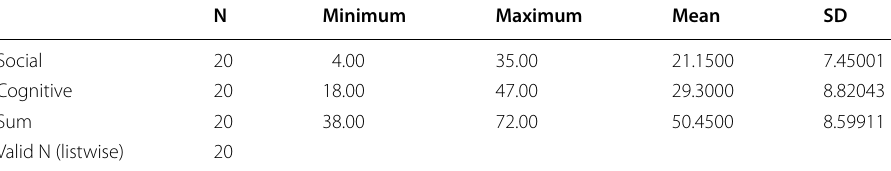
Table 7 Descriptive statistics of online interaction of top twenty students